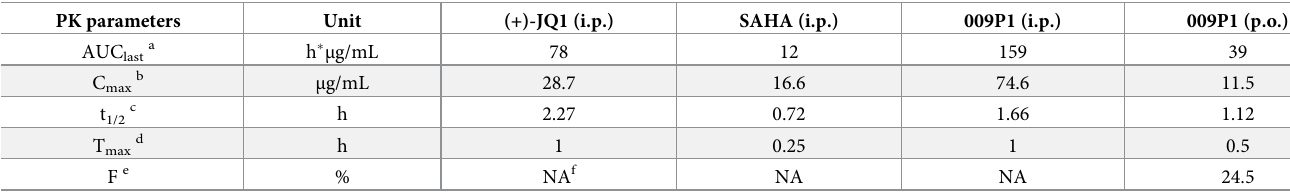
Table 4. Pharmacokinetic studies of (+)-JQ1, SAHA, and 009P1 in mice. PK parameters Unit (+)-JQ1 (i.p.) SAHA